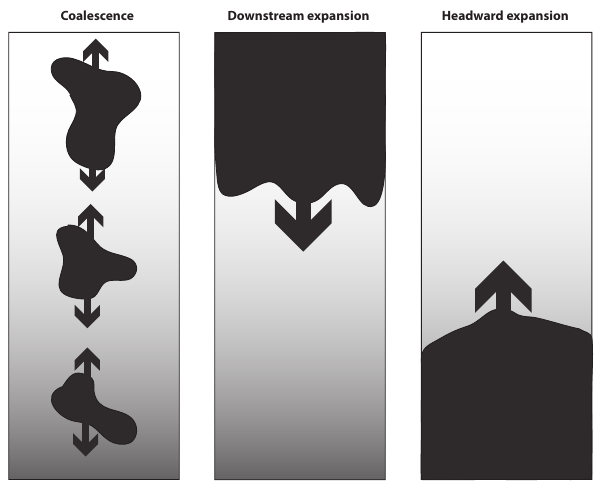
Fig. 8. Models of stream network expansion. Coalescence: the formation of individual pools which join to create a flowing net- work; Downstream expansion: movement of water from upstream to downstream; Headward expansion: movement of the channel head upstream.